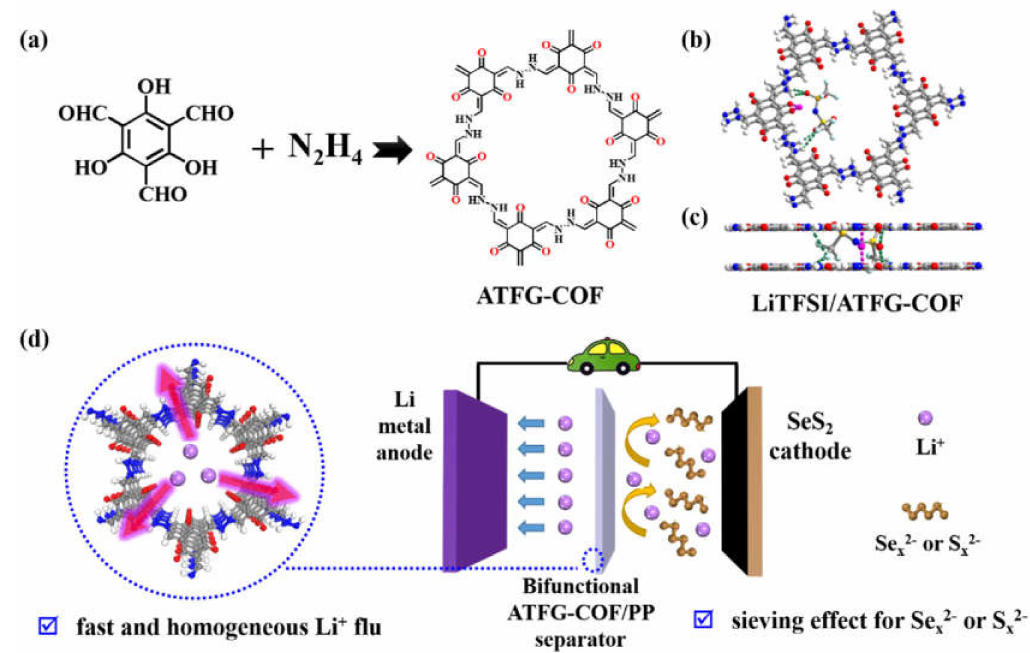
Figure 1. ( a ) Scheme of the structure of ATFG-COF. DFT calculation of the hydrogen bond in LiTFSI/ATFG-COF: ( b ) Top view and ( c ) side view. ( d ) Scheme of bifunctional ATFG-COF/PP separator of inhibition of lithium dendrite and shuttle effect in Li-SeS 2